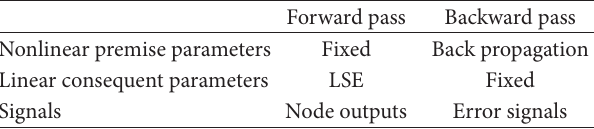
Table 4: Two passes in the hybrid learning of ANFIS.